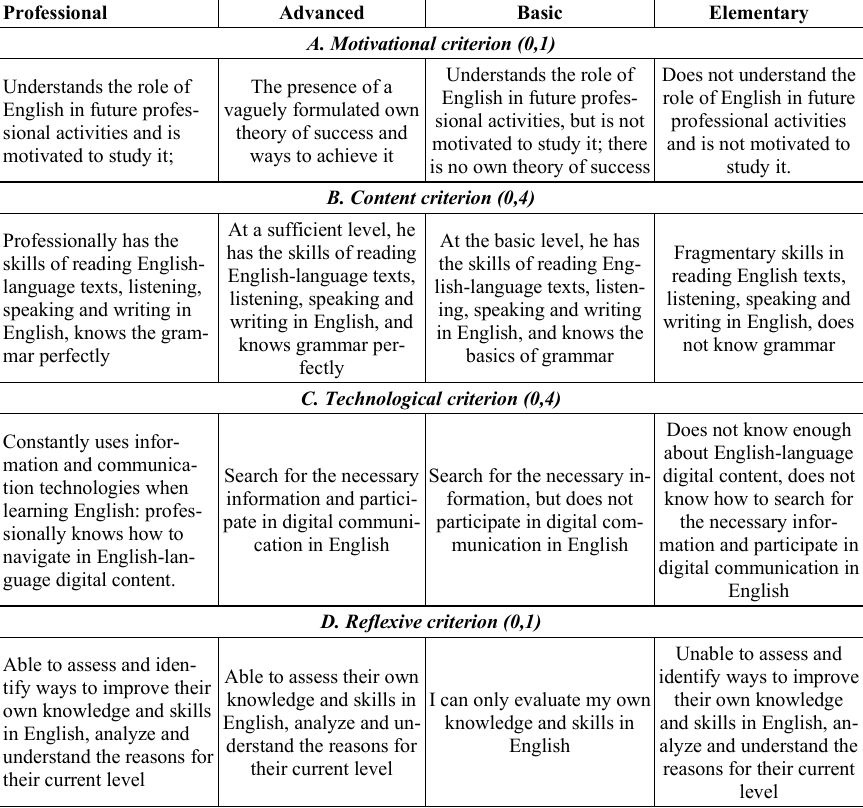
Table 3. Niveaux de formation des compétences professionnelles en langues étrangères des futurs bacheliers-philologues selon les critères suivants. Professional Advanced Basic